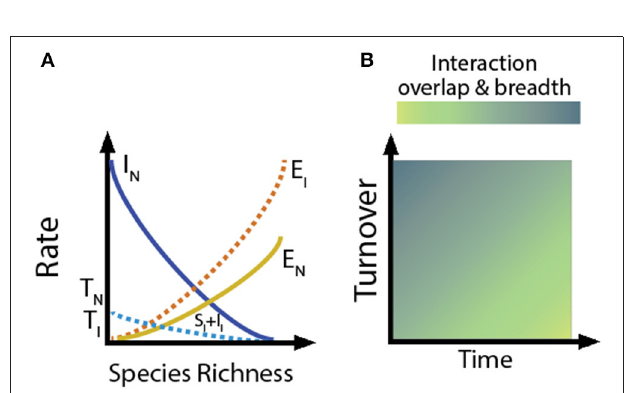
FIGURE 2 | Extension of classical theory of island biogeography to understanding how network structure changes as communities assemble. (A) For a given area, the rate of species turnover will depend on the rates of immigration, speciation, and extinction in a community. The species extinction rate near source pools ( E N ) will be lower than that far from source pools ( E I ) because of the rescue effect. Similarly, immigration rates ( I I ) will be lower for communities far from source pools, but speciation ( S I ) will be higher. Because the intersection between E N and I N (solid lines) is greater than the intersection between E I and S I + I I (dashed lines), the rate of species turnover in the community near the source pool ( T N ) is higher than in the more isolated community ( T I ). (B) Low rates of species turnover and many generations of evolution/coevolution will favor niche partitioning and specialization, whereas high turnover will favor niche overlap and